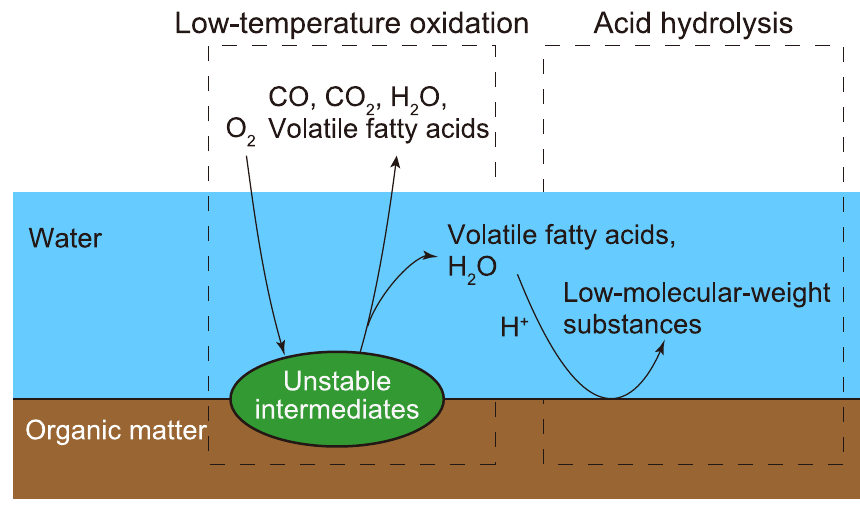
Fig 7. Biomass decomposition below 100